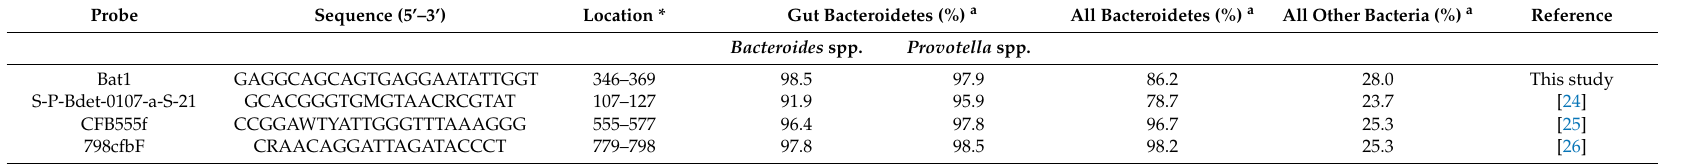
Table 3. Comparison of our probe with previously reported Bacteroidetes-specific probes.